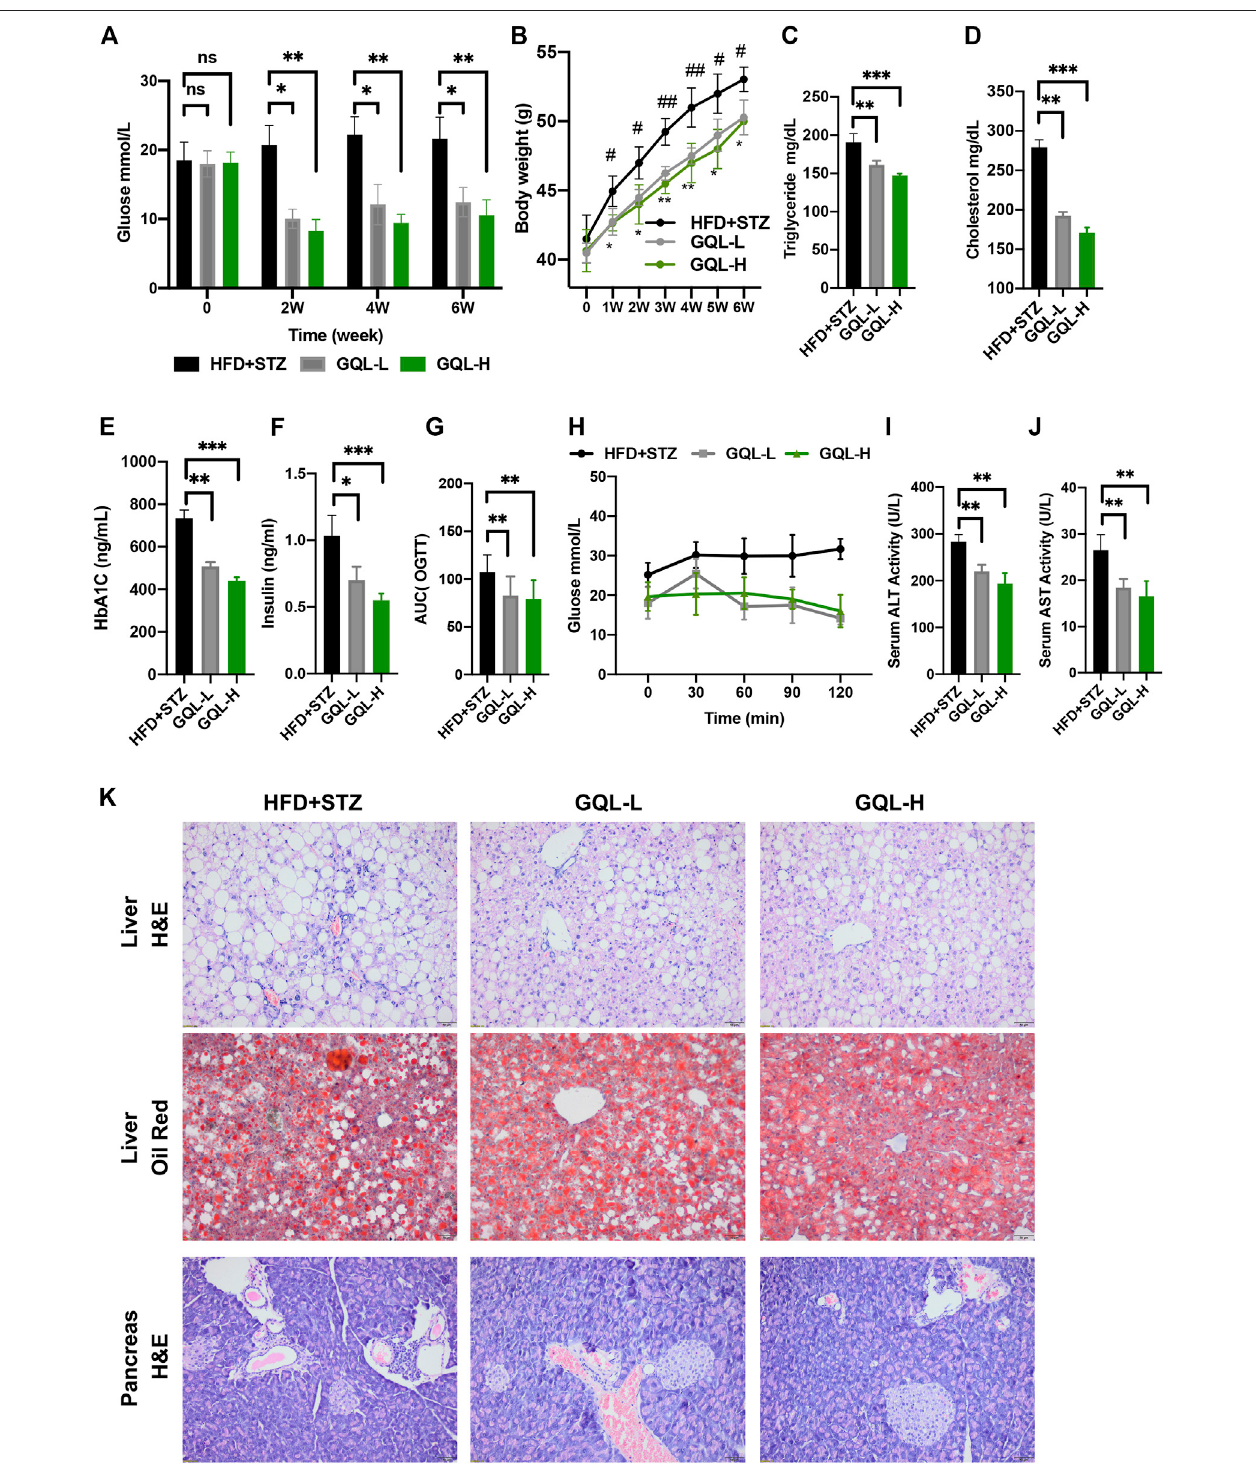
FIGURE 5 | (A) Fasting blood glucose changes in HFD + STZ-treated C57BL/6 mice after GQL treatment; (B) body weight elevation; (C,D) triglyceride and cholesterol levels; (E,F) HbA1c and insulin levels; (G) glucose AUC during OGTT; (H) glucose levels during OGTT measured 0, 30, 60, 90, and 120 min after oral administration of glucose solution (2 g/kg); (I,J) serum ALT and AST levels.